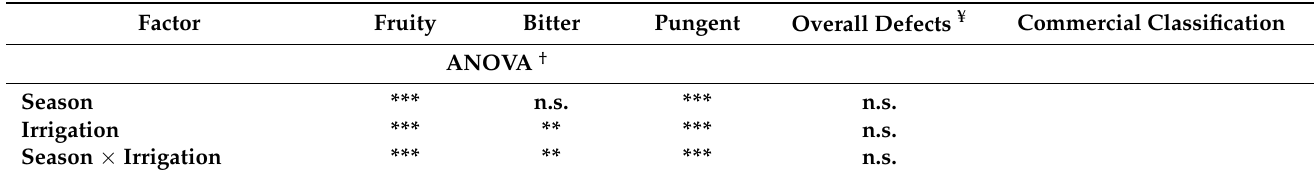
Table 6. Sensory profile (fruity, bitter, pungent and overall defects) by the trained panel of ‘Arbequina’ olive oil samples obtained from a super-high-density olive tree orchard with deficit irrigation. Factor Fruity Bitter Pungent Overall Defects ¥ Commercial